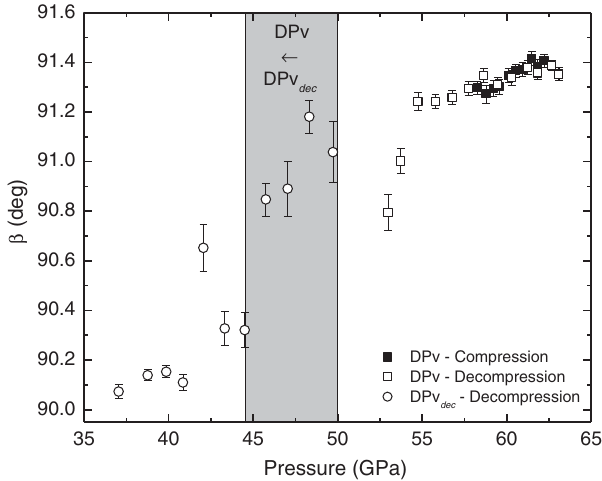
FIG. 9. Monoclinic distortion of the double-perovskite phase of Fe 2 O 3 . Pressure evolution of the β angle, characteristic of the monoclinic distortion of the unit cell with P 2 1 =n symmetry (DPv structure), upon compression and decompres- sion (solid and open symbols, respectively). Note the signifi- cant decrease of the monoclinic distortion coinciding with the reverse electronic transition to the strongly correlated state upon decompression; the β angle changes from 91.4° to 90.1°.